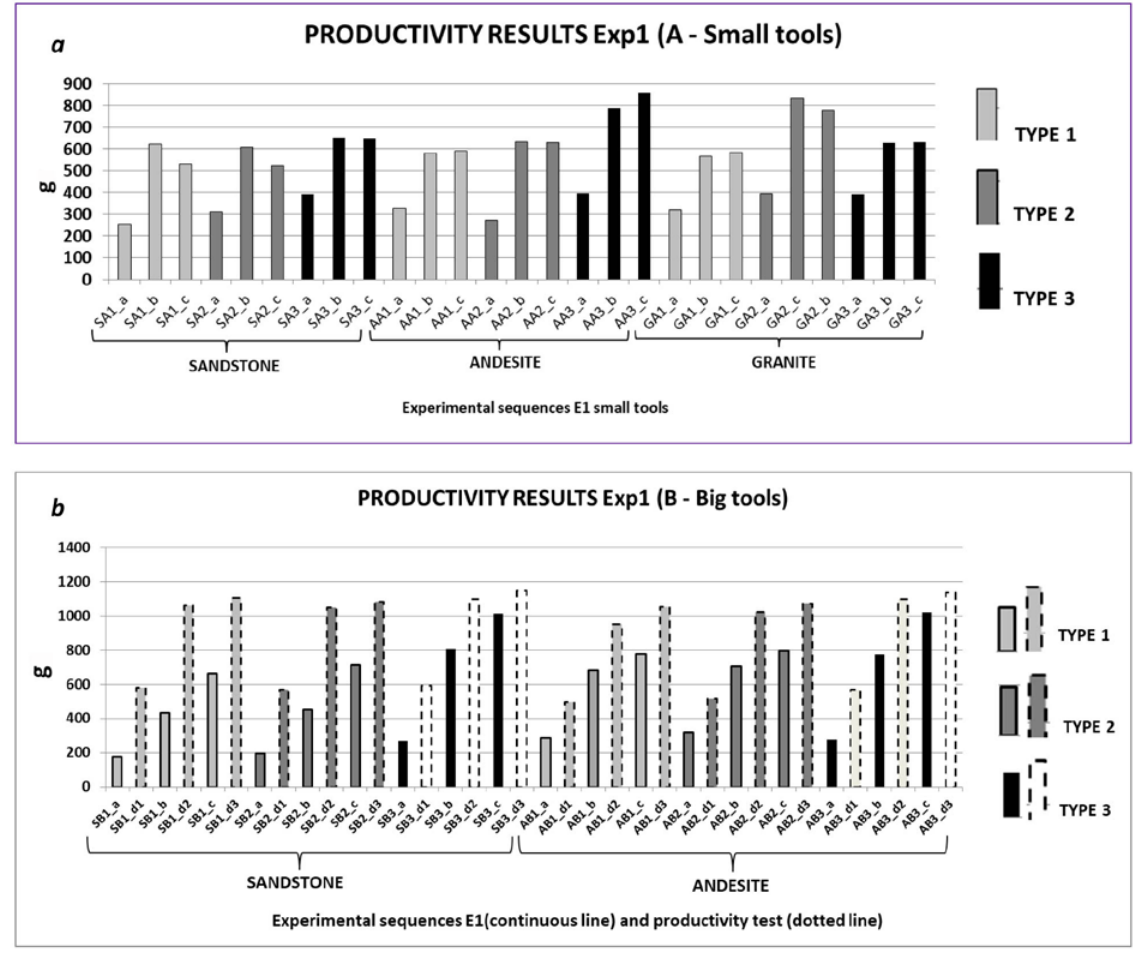
Figure 5. Results of Experiment 1 – small tools (a, above) and big tools (b, below). The dotted lines indicate the sequences done in the productivity test . Times in all experimental sequences are stable: _a= 60 min; _b=120 min;_c =120 min; _d1= 60min; d2_120 min;_d3 = 120 min. Codes of grinding tools are in Table